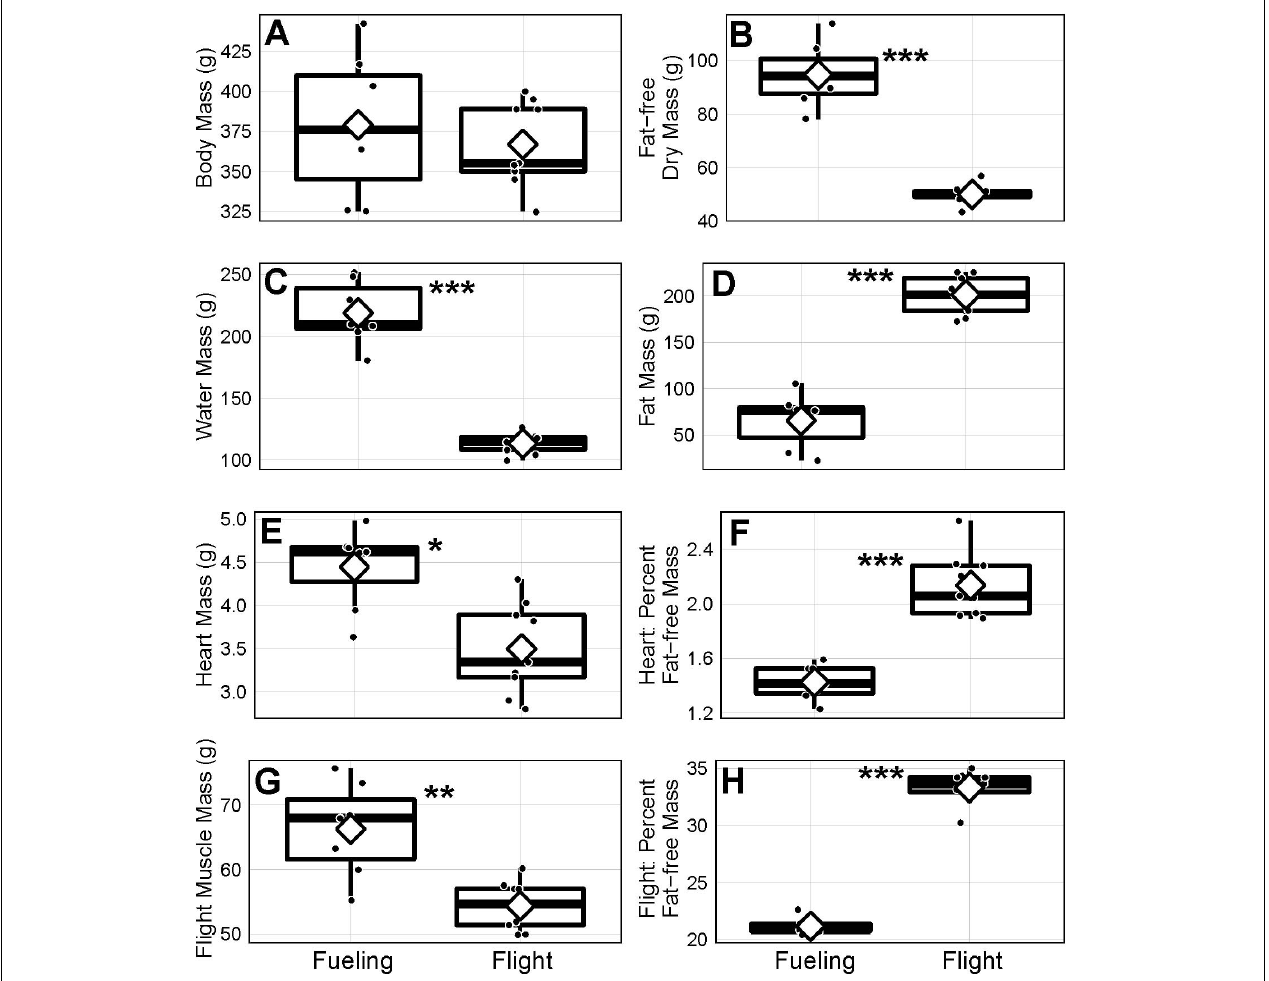
FIGURE 1 | Mass (A–E,G) and mass relative to fat-free mass (F,H) of body components of juvenile bar-tailed godwits sampled in Alaska, United States, during the fueling ( n = 2 females and 5 males) and flight ( n = 9 males) annual-cycle stages of their first southward trans-Pacific migration. Horizontal lines represent the median, diamonds the mean, black circles the actual values, boxes the 25th and 75th percentiles, and whiskers the range of values. Statistically significant group differences based on analysis of variance analyses controlling for effects of sex represented by * p ≤ 0.05, ** p ≤ 0.01, and *** p ≤ 0.001.